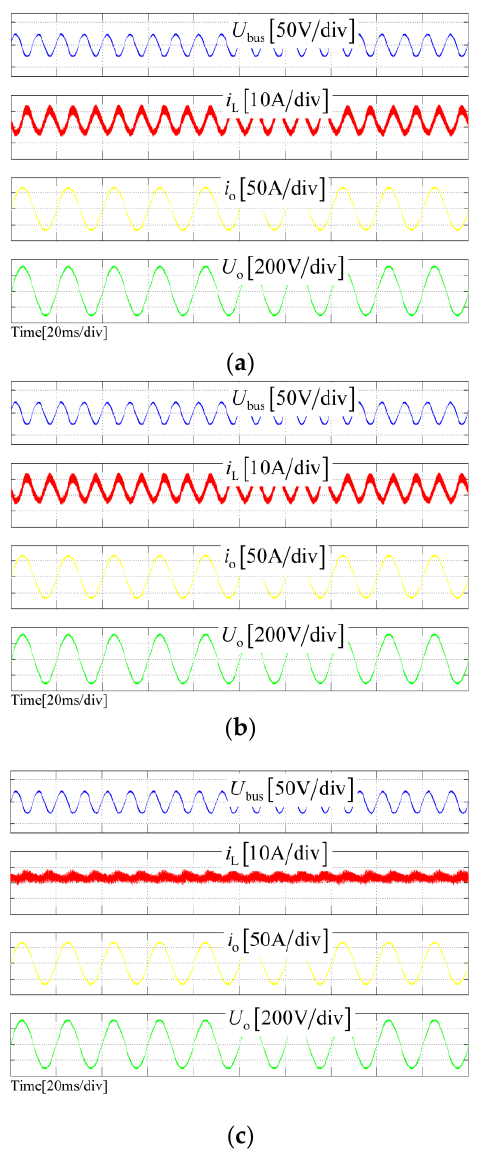
Figure 12. Steady-state simulation results. ( a ) Scheme I; ( b ) scheme II; ( c ) proposed NICFPS.